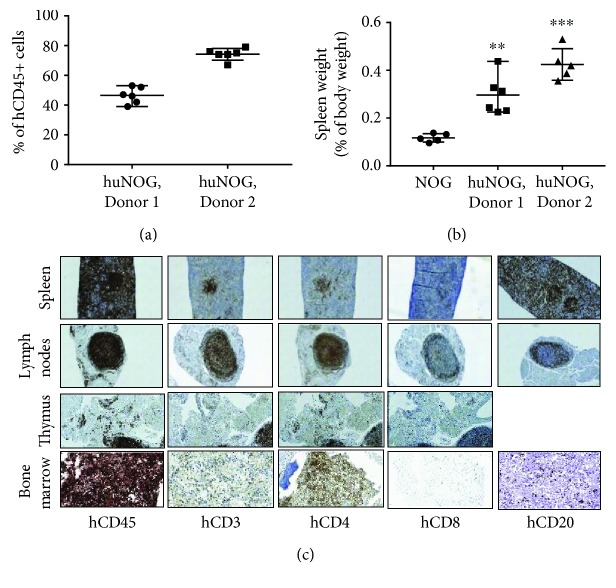
Immune cells in huNOG mice. (a) Chimeric ratio of hCD45/mCD45+ cells (%, median ± min/max) in huNOG mice engrafted with cells from two different donors (Donor 1 and Donor 2). (b) Spleen weight relative to body weight at sacrifice (%, median ± min/max). Prior to statistical analysis, the data was transformed using logarithmic transform. Statistical analysis was performed using ANOVA and pairwise comparisons using Dunnett's test. Statistical significance is marked as ∗∗
p < 0.01 and ∗∗∗
p < 0.001. (c) Representative images of immunohistochemical stainings for different human immune cells (hCD45: common leukocyte antigen, hCD3: T cells, hCD4: T helper cells, hCD8: cytotoxic T cells, and hCD20: B cells) in immune-related organs of huNOG mice. Magnification 10x for the spleen, lymph nodes, and thymus and 40x for the bone marrow.